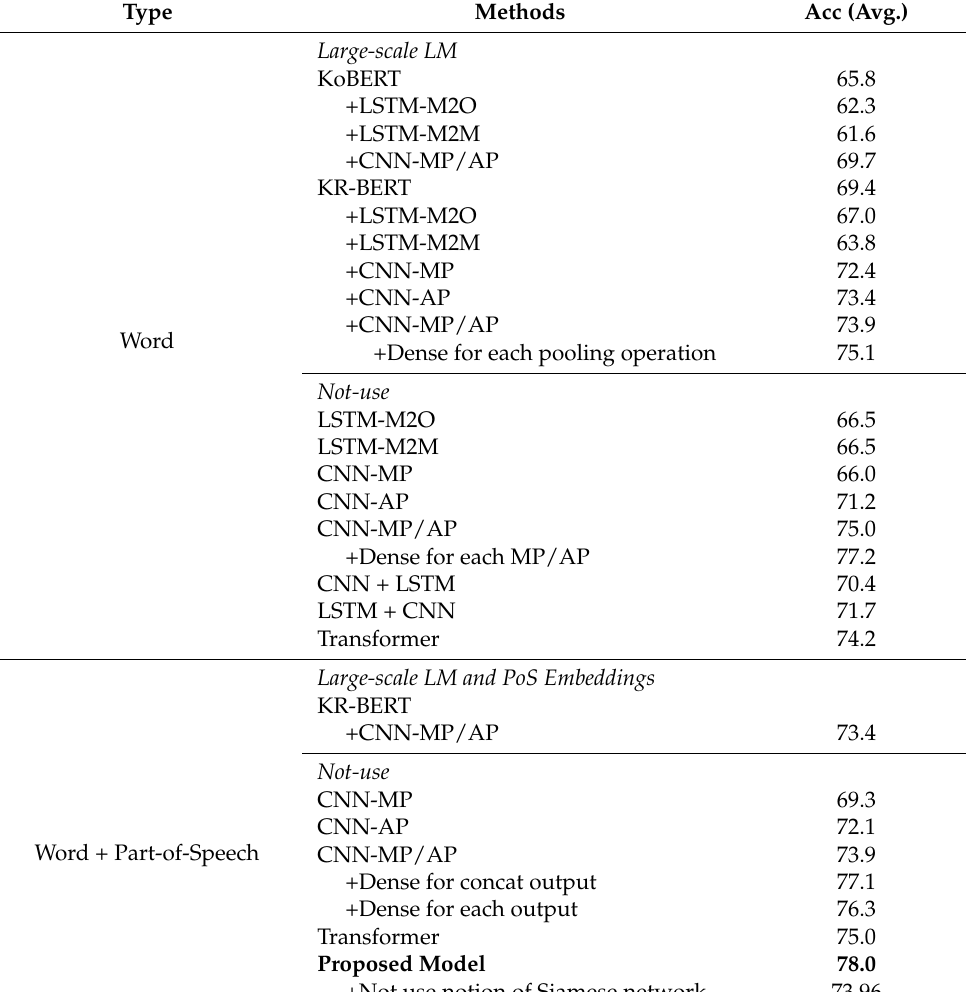
Table 6. Experimental results.